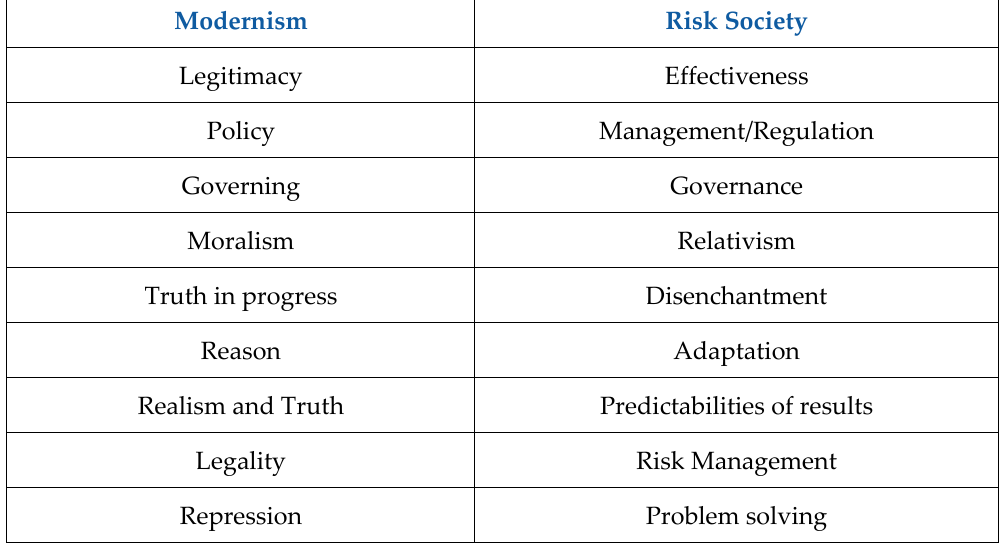
Figure 1. Paradigm shift between modern society and the risk society (source: Barlatier 2017, p. 48).